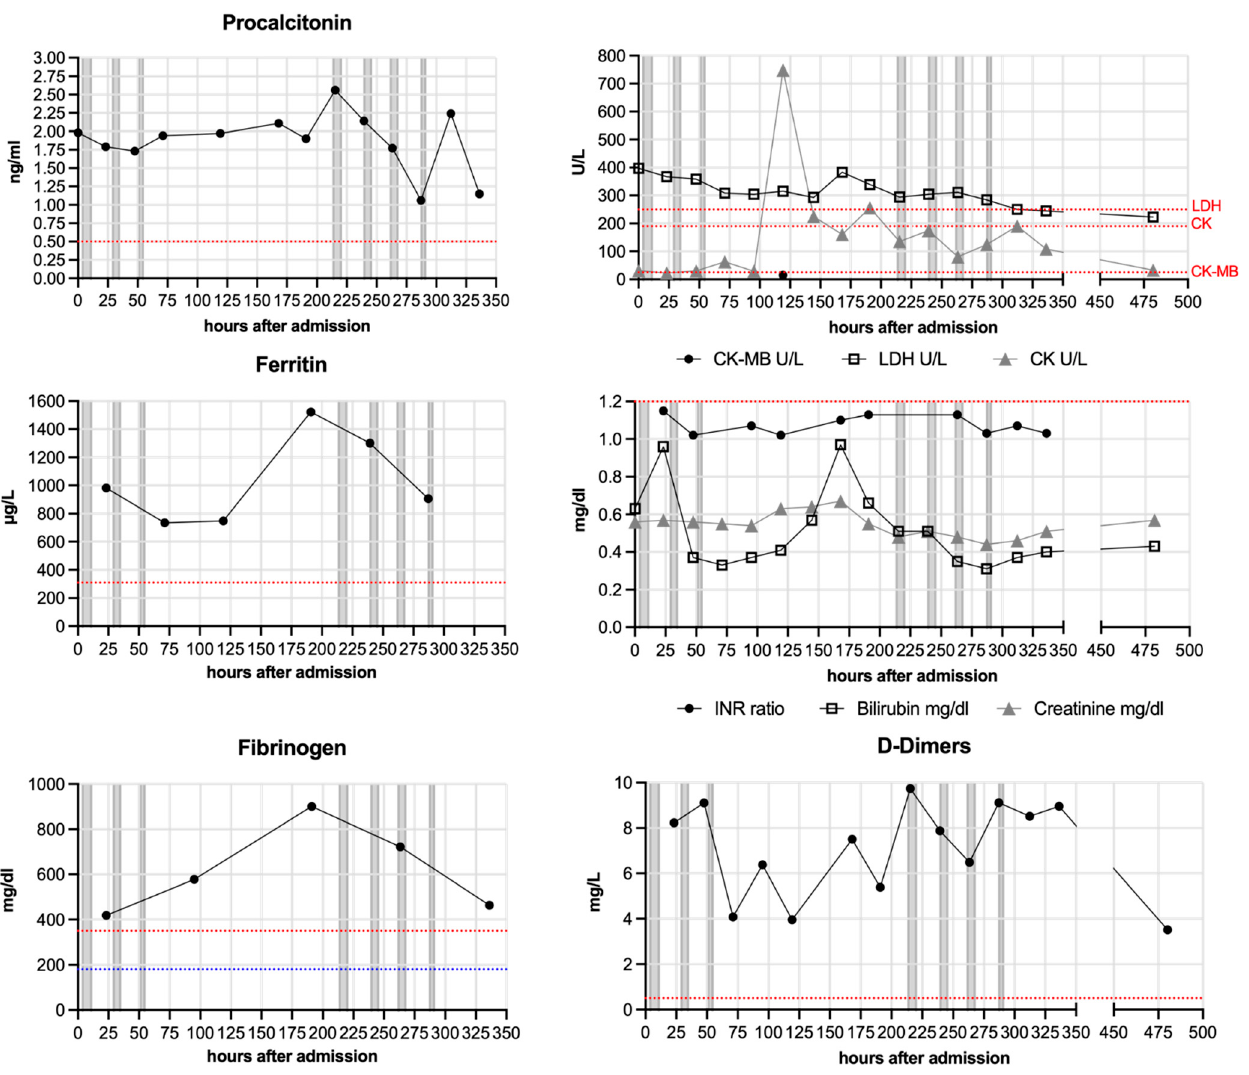
Figure 4. Other laboratory parameters of one patient (patient 4). Procalcitonin, CK-MB, CK, LDH, Ferritin, INR ratio, Bilirubin, Creatinine, Fibrinogen and D-Dimers were measured regularly for each patient and are depicted here representatively for patient 4. Blue lines indicate minimum baseline and red lines maximum baseline for each normal range. Grey bars indicate apheresis treatments.